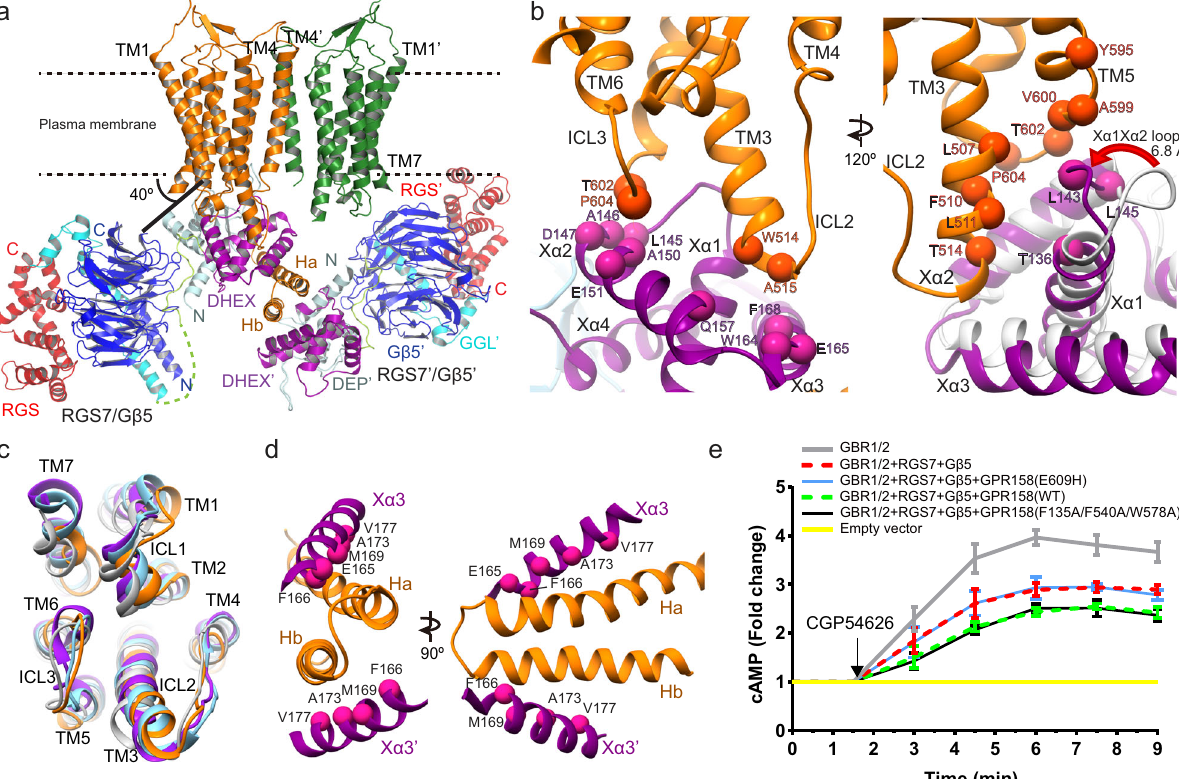
Fig. 5 Cryo-EM structures of the GPR158 – RGS7 – G β 5 complex. a Overall structure of the 2GPR158 – 2RGS7 – 2G β 5 complex. Each domain is colored as follows: each 7TM domain of GPR158, orange and green, respectively; DEP, light cyan; DHEX, purple; GGL-RGS linker, light green; GGL, cyan; RGS, red; G β 5, blue. The disordered region between DHEX and GGL domains is indicated by a light green dotted line. b Close-up view of the interaction between the DHEX domain and GPR158. Residues at the interface are shown as spheres. The 120°-rotated view (right) highlights the conformation change of the X α 1X α 2 loop upon GPR158 binding. The RGS7 bound to GPR158 is aligned with the RGS7 – G β 5 dimer 47 (PDB 6N9G, light gray). c Superimposed 7TM domain of GPR158 bound to RGS7 – G β 5 (orange) with each 7TM domain of the GABA B - Gi (PDB 7EB2, light gray), mGluR2 - Gi (PDB 7MTS, purple), and mGluR4 - Gi (PDB 7E9H, sky blue) viewed from the bottom. d Interactions between X α 3 and the cytoplasmic helices in two views. e CGP54626-induced cAMP production using HEK293T cells expressing indicated GPR158 mutants. Data represent mean values with standard deviations from three independent